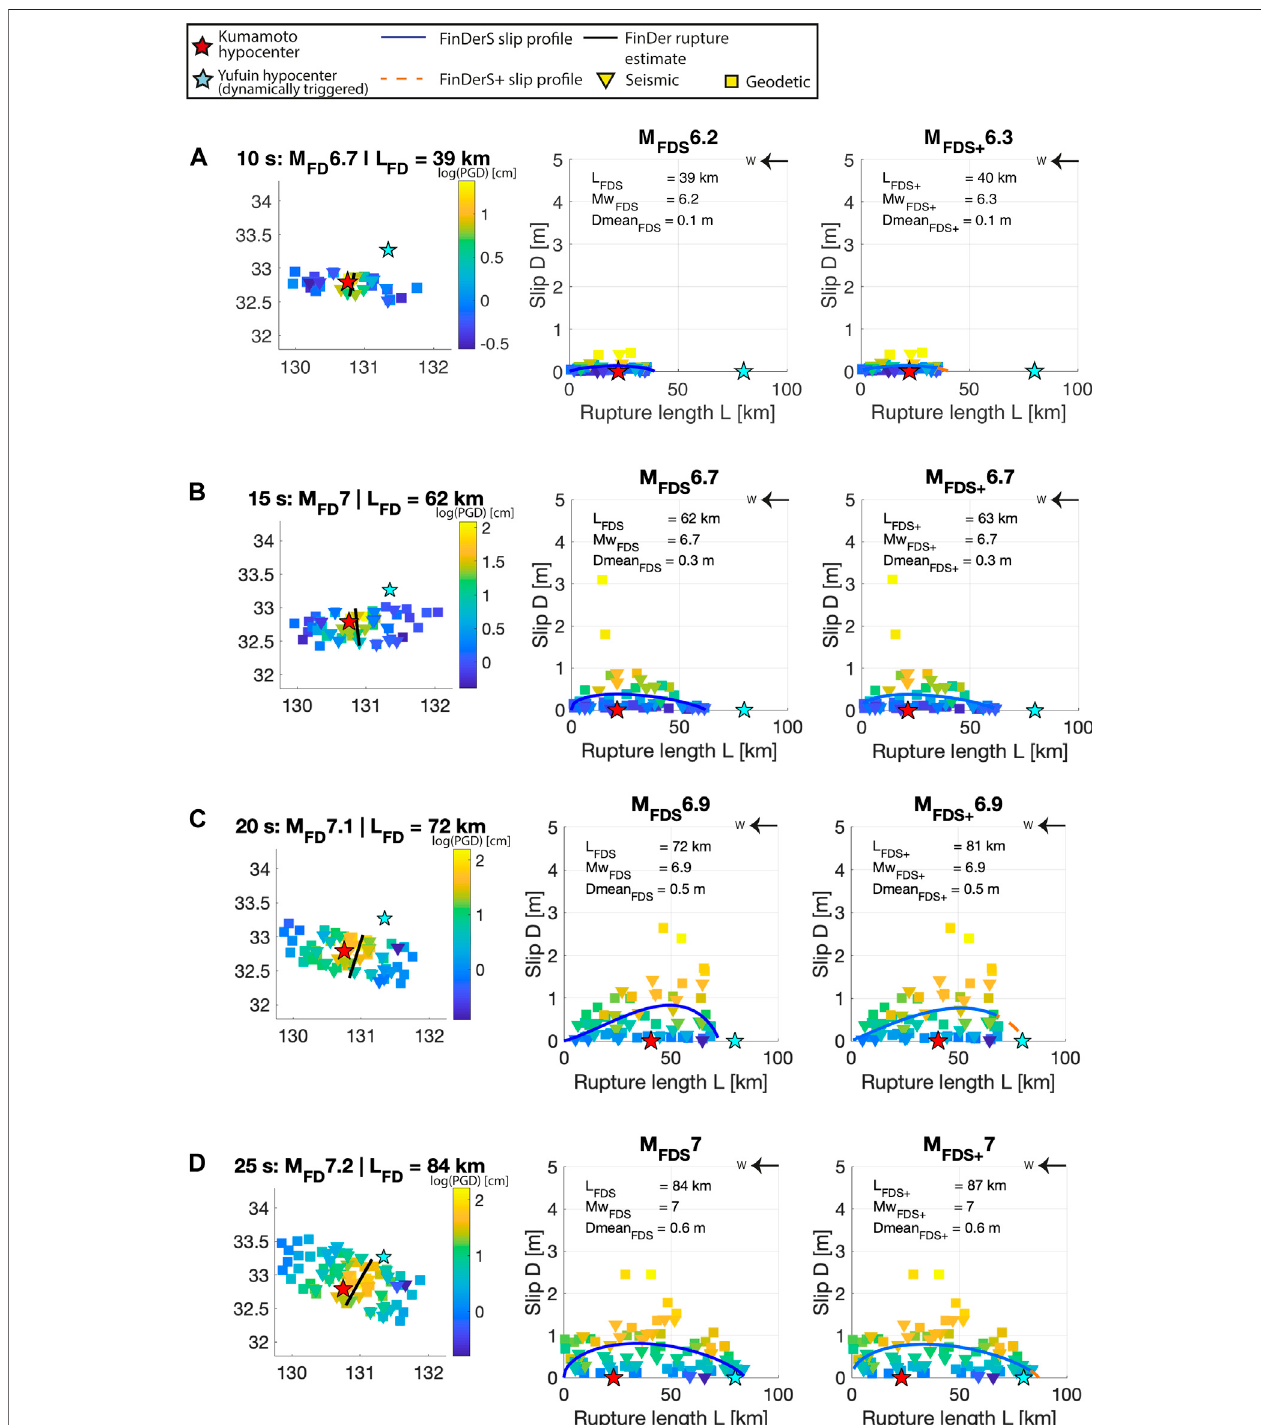
FIGURE 6| Playback results for the M W 7.0 Kumamoto earthquake (L ∼ 40 km, ∼ 15 srupture duration) at a) 10 s, b) 15 s, c) 20 s, and d) 25 s from event origin. Follows Figure 5 . See Table 2 for details.